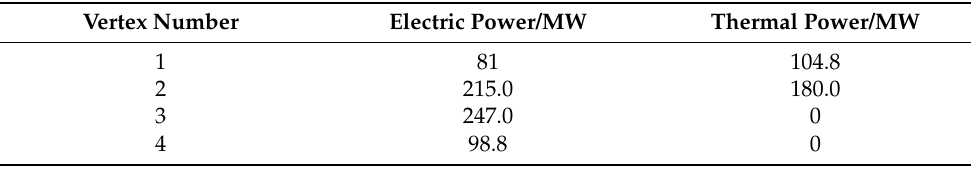
Figure 4. Electric–gas–heat integrated energy system structure diagram.